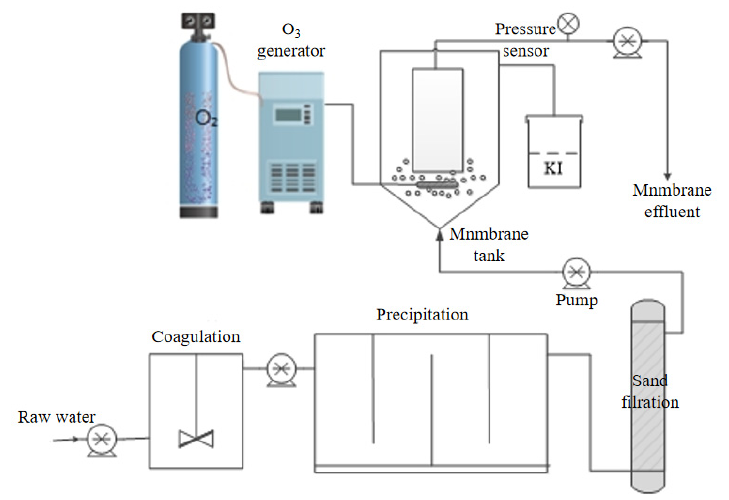
Figure 1. Diagram of the combined process